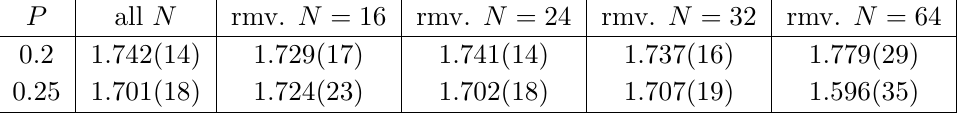
Table 7. Values of c con for W con with data for different N removed. Without n t = 16 . P all N